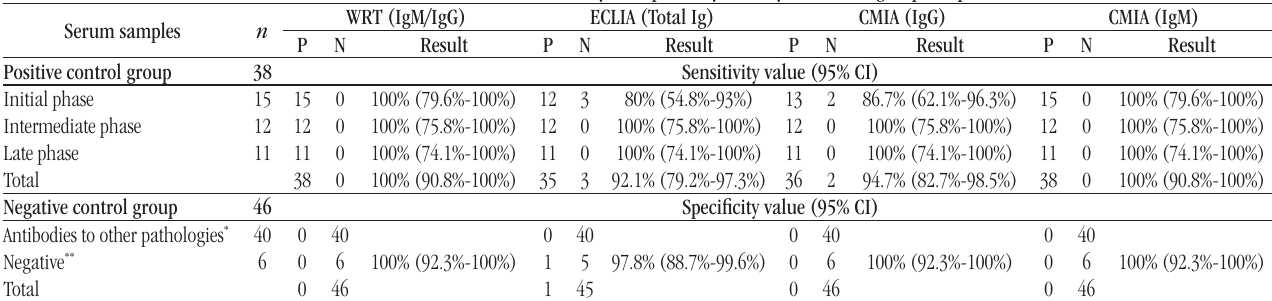
TABLE 1 – Estimated values of sensitivity and specificity of assays in control group samples